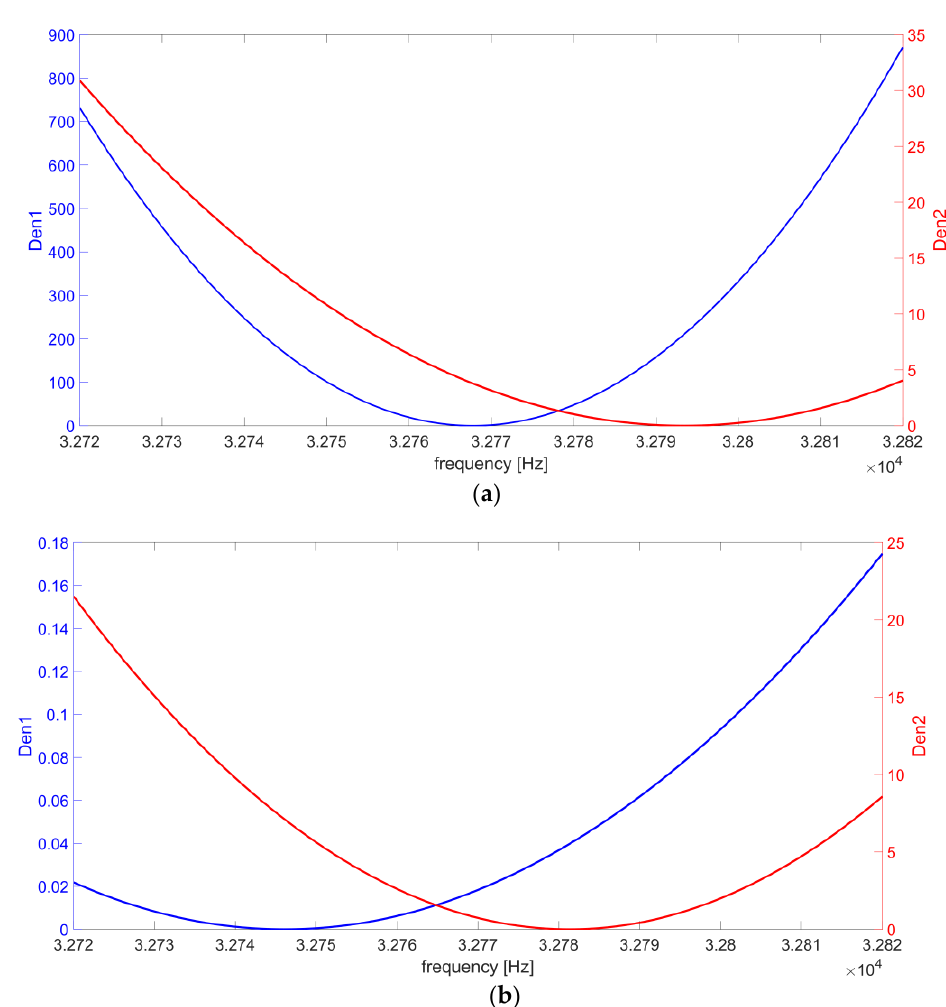
Figure 6. Behavior of Den1(f) and Den2(f) in Equation (3) as a function of frequency for ( a ) R L = 100 k Ω and ( b ) R L = 10 M Ω .